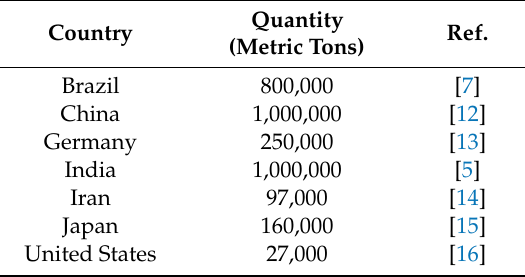
Table 1. Quantities of apple pomace production in certain countries.